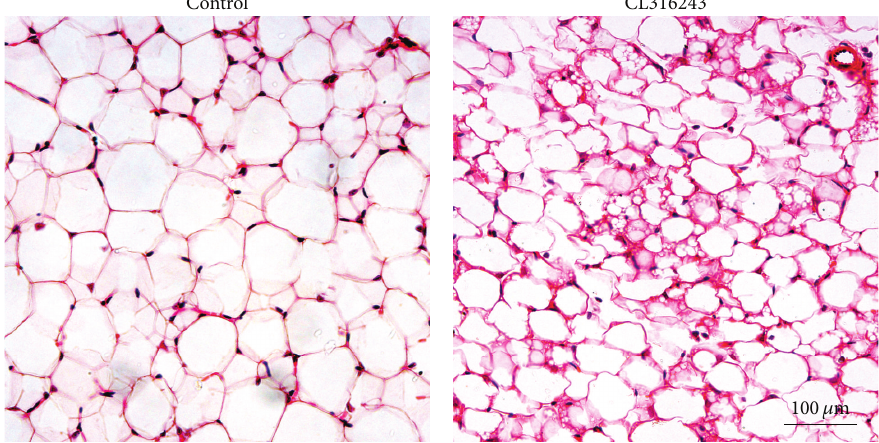
Figure 2: Photomicrographs of paraffin-embedded hematoxylin and eosin stained sections from epididymal adipose